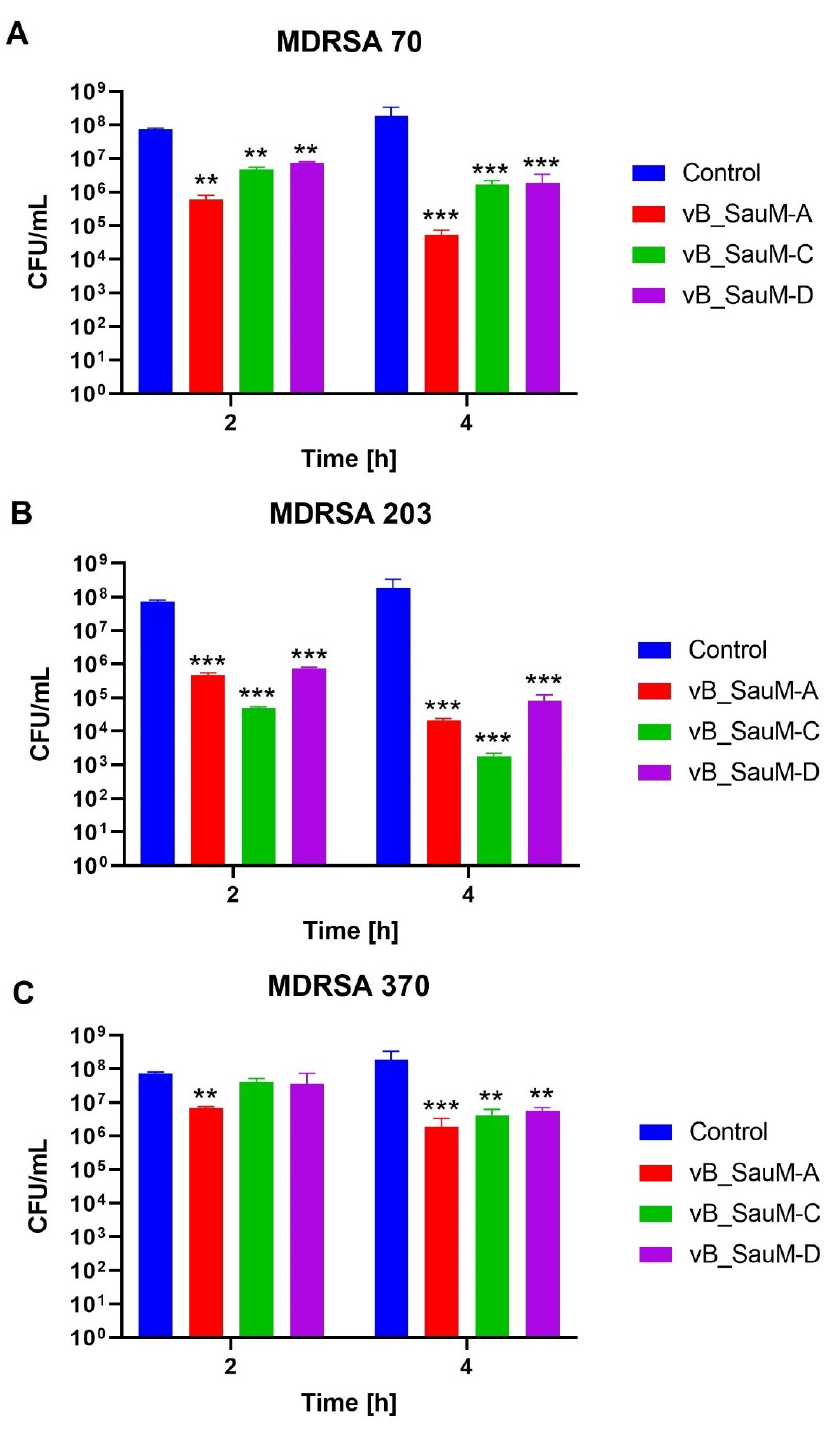
Figure 4. The CFU/mL of MDRSA strains 70 ( A ), 203 ( B ) and 370 ( C ) treated with phages vB_SauM-A, vB_SauM-C and vB_SauM-D at 10 7 PFU/mL after 2 and 4 h of incubation in comparison to the negative control (non-treated with phages). Mean values from three independent experiments are shown, with error bars representing SD. Statistical analysis was performed using the Kruskal–Wallis test followed by Dunn’s multiple comparison test for values with nonparametric distribution, with ** p < 0.01 and *** p < 0.001.